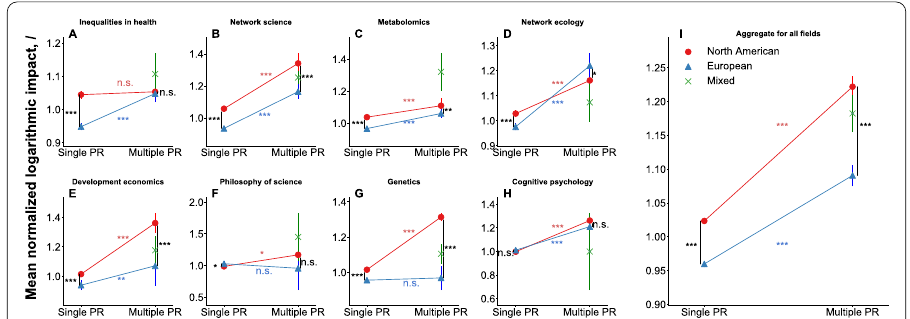
Figure 4 Impact difference under different collaborative strategies. Mean normalized logarithmic impact for articles authored by either a single prominent researcher (PR) or multiple PR in: ( A ) inequalities in health, ( B ) network science, ( C ) metabolomics, ( D ) network ecology, ( E ) development economics, ( F ) philosophy of science, ( G ) genetics and ( H ) cognitive psychology. The normalized logarithmic impact I i of a paper i is the logarithmic number of citations (plus 1) log( k i + 1) of the paper divided by the mean of the logarithmic number of citations (plus 1) of papers with no prominent researcher collaboration in the same publication year (Methods). ( I ) Aggregated normalized logarithmic impact for all fields. Stars indicate significant differences (***: 1%, **: 5%, *: 10%, n.s.: not significant). See Supplementary Fig. S11 for the whole distributions of the logarithmic number of